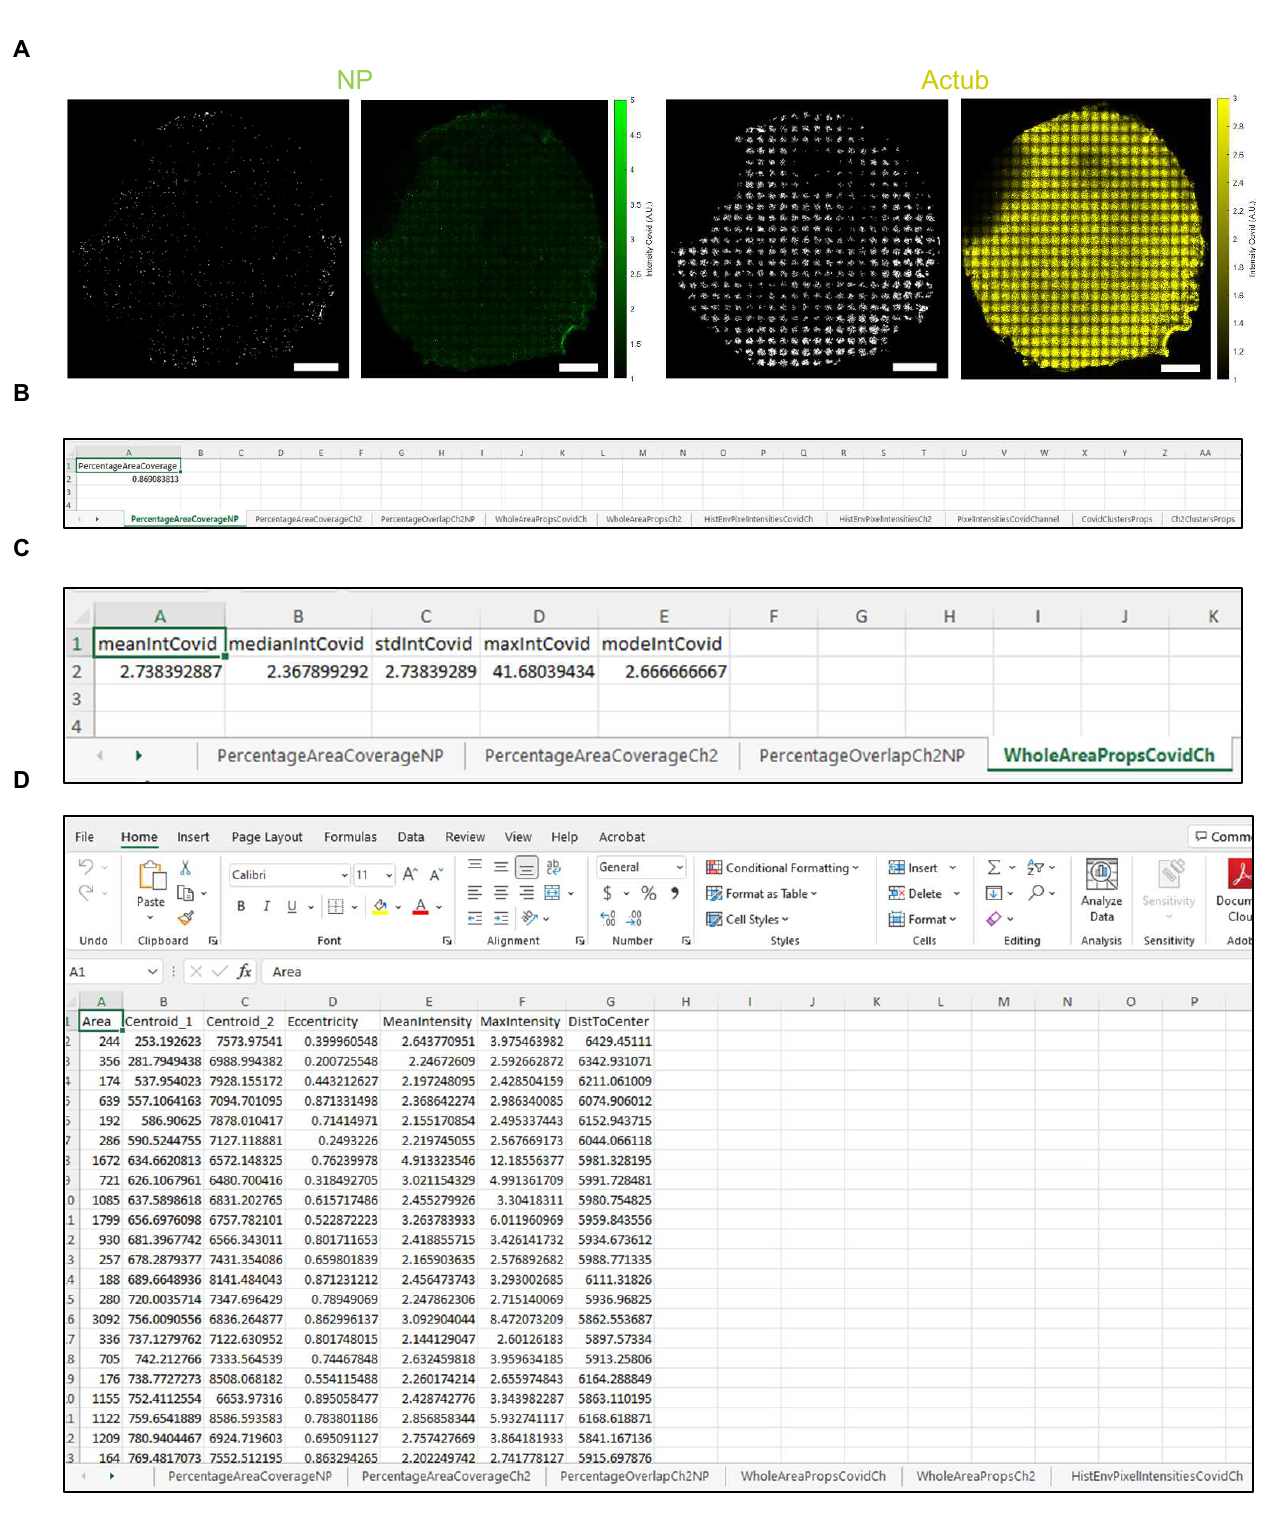
Figure 5. Representative graphical user interface analysis of data from CF air-liquid interface cultures. ( A ) Binary (left) and background corrected images (right) of SARS nucleocapsid protein (NP, green) and acetylated tubulin (Actub, yellow). Scale bars: 1 mm. ( B ) Area coverage (%) of NP signal. ( C ) Intensity statistics of the NP signal. ( D ) Statistics of the clusters after segmentation and filtering, for the NP and Actub signal.